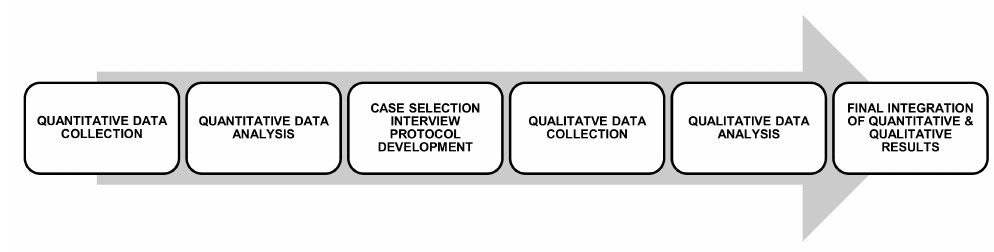
Figure 1. Summary of Sequential Explanatory Mixed Methods research